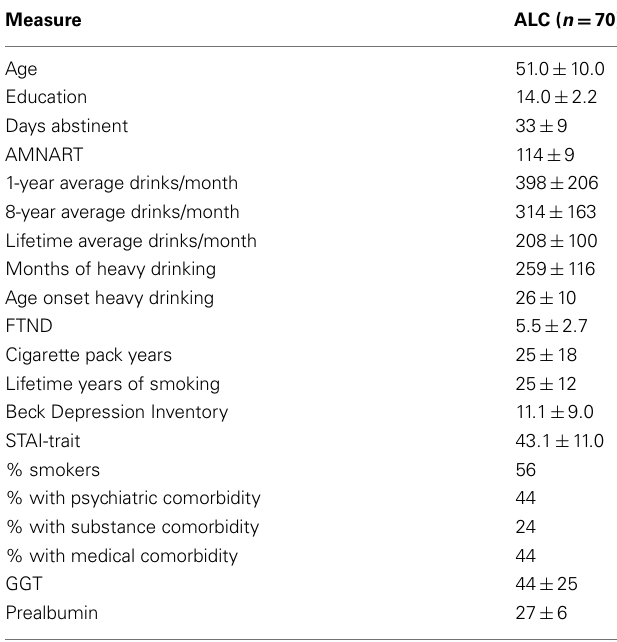
Table 1 | Participant demographics and clinical